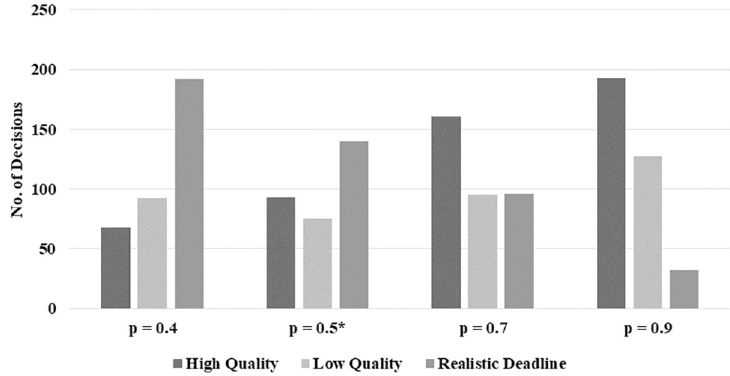
Fig 6. Distribution of unrealistic deadline (high-quality and low-quality decisions) and realistic deadline situations per treatment (n = 352, � n = 308).